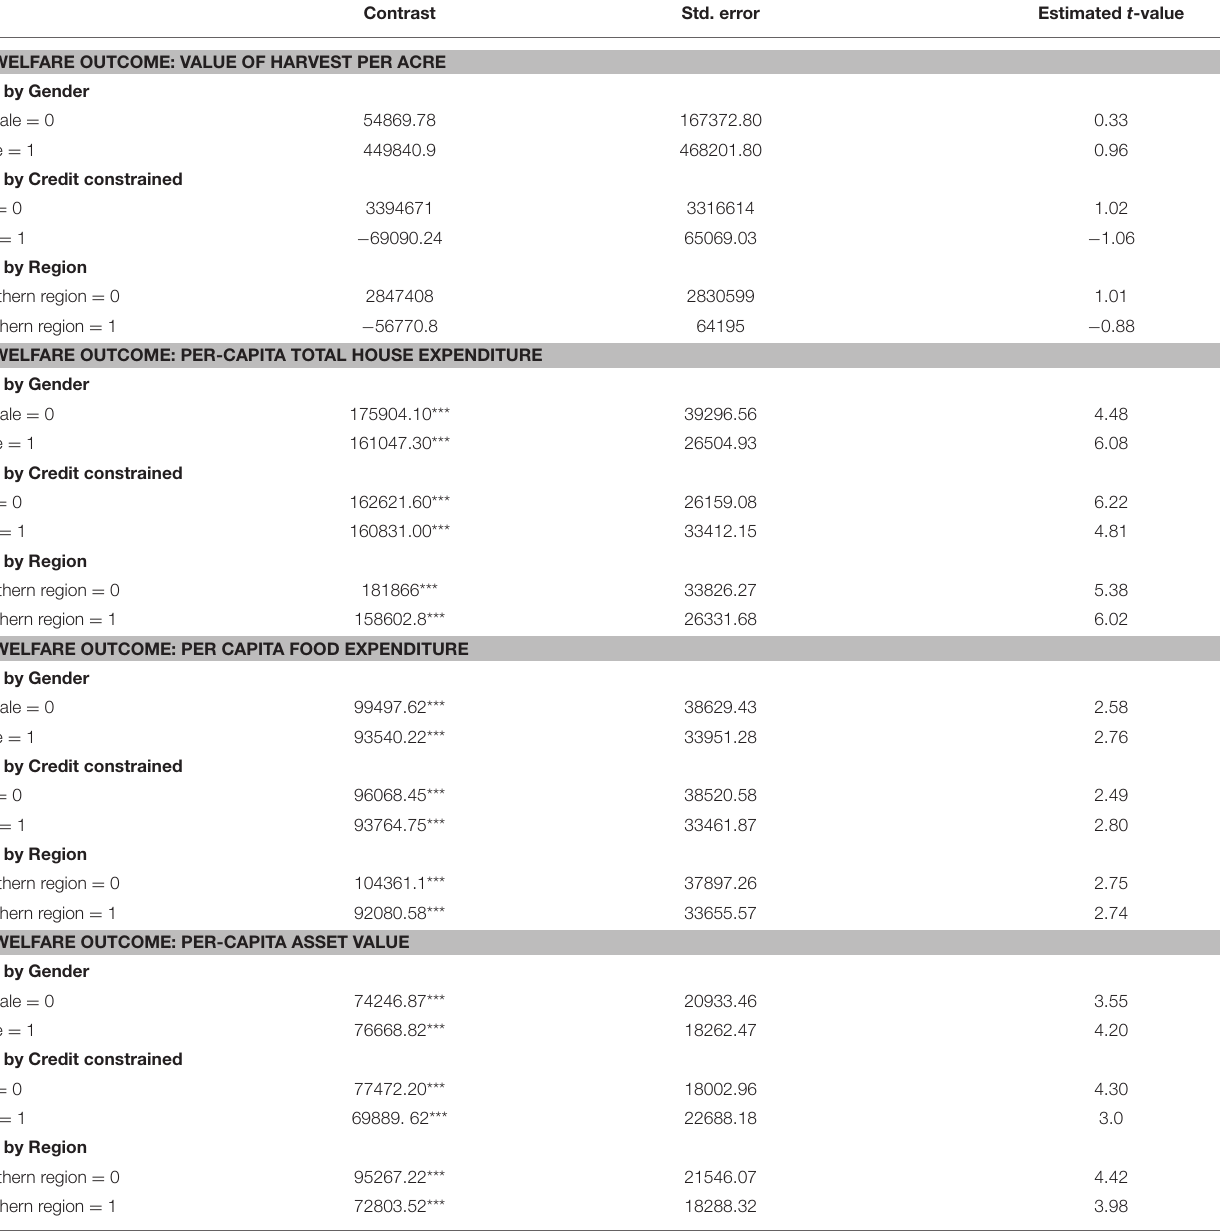
TABLE 7 | Heterogenous impact of adoption of organic fertilizers. Contrast Std. error Estimated t